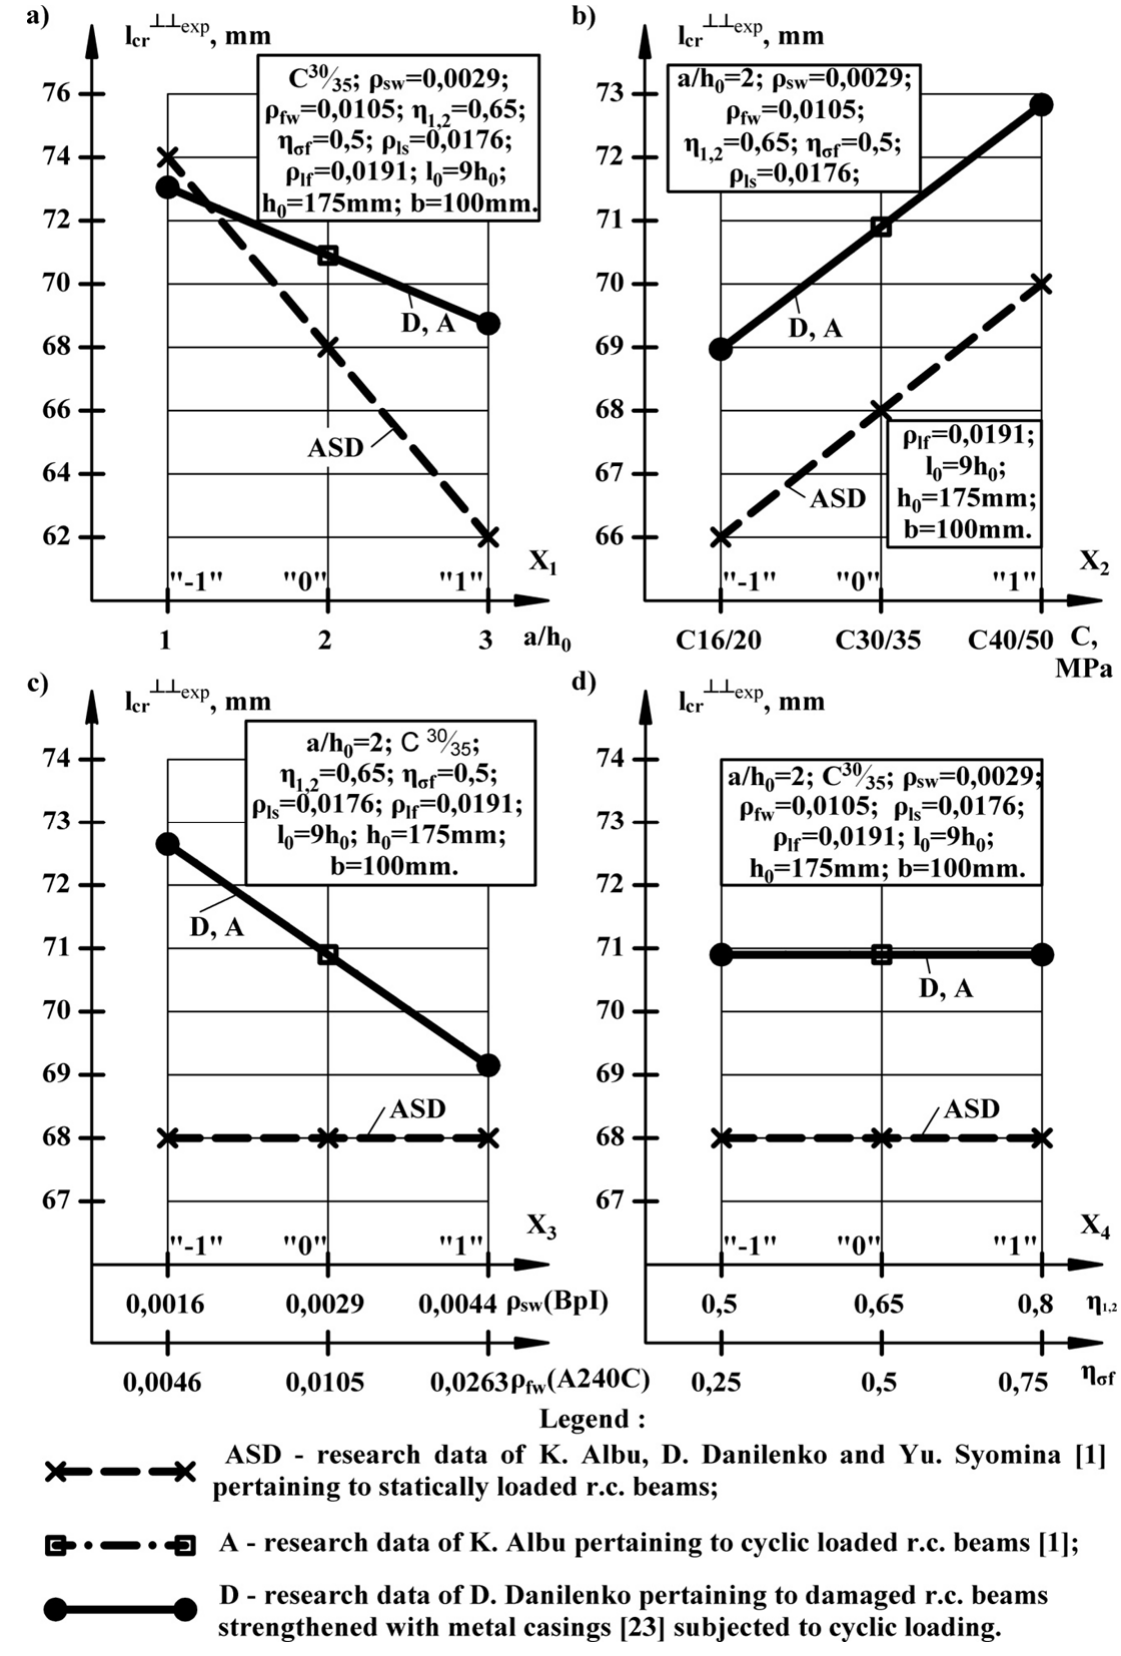
Figure 6. dependence of the distance between normal cracks prior to collapse on the value of the relative shear span ( а ), concrete grade (b), quantity of the transverse reinforcement (c), levels of the transverse loading and prestress of the metal casing elements